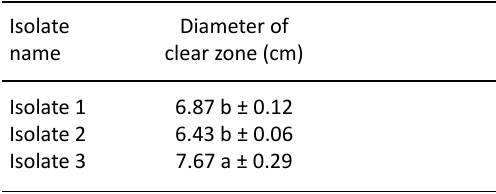
Table 3. The qualitative evaluation of the fungal protease activity on GYP medium